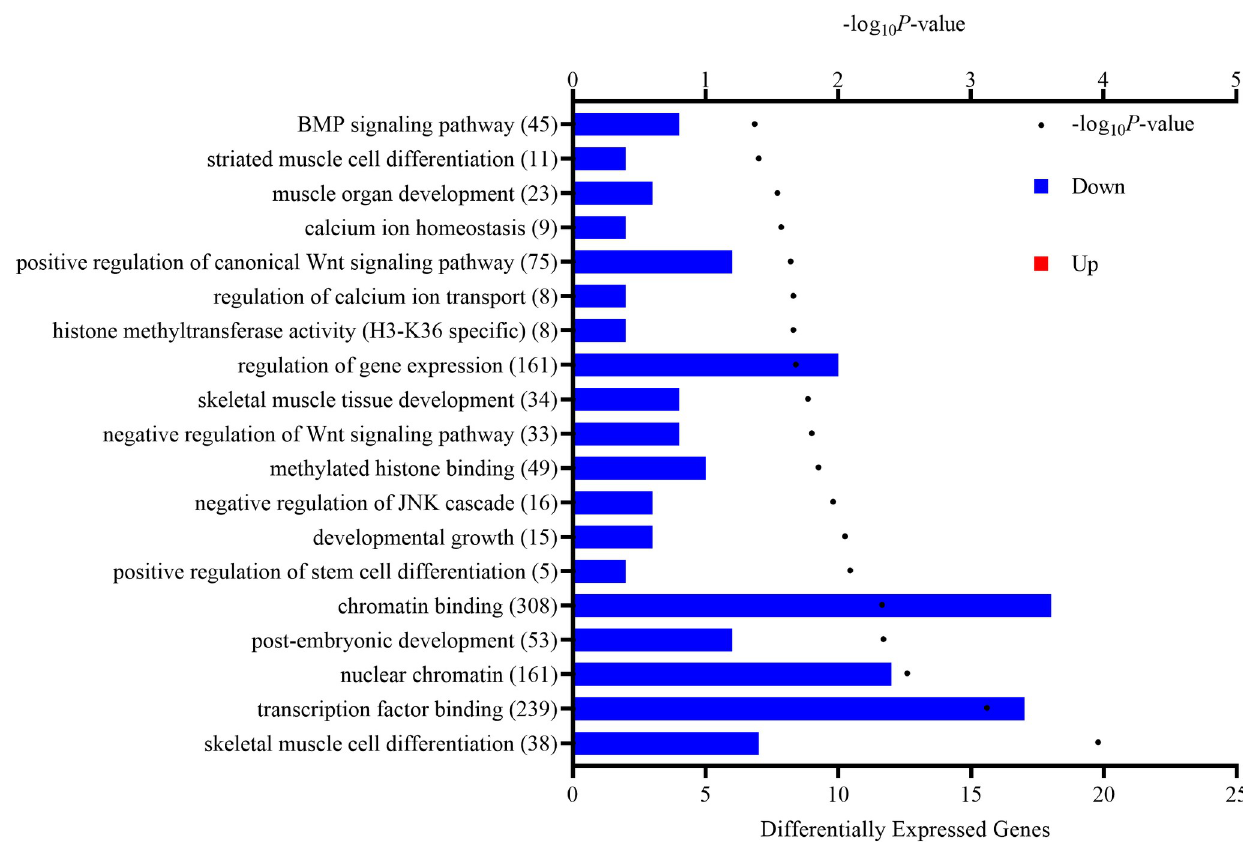
Fig 1. Significantly enriched gene ontology (GO) terms in the Longissimus dorsi of early-weaned Bos indicus -influenced calves for the effect of maternal supplementation with protein and energy. The number of differentially expressed genes ( P � 0.025) is reported along the bottom x-axis and is depicted by the bars while the -log 10 P -value is reported along the top x-axis and is indicated by the dots. Blue bars indicate downregulated genes while red bars indicate upregulated genes. The number in parentheses is the total number of genes associated with each functional term.